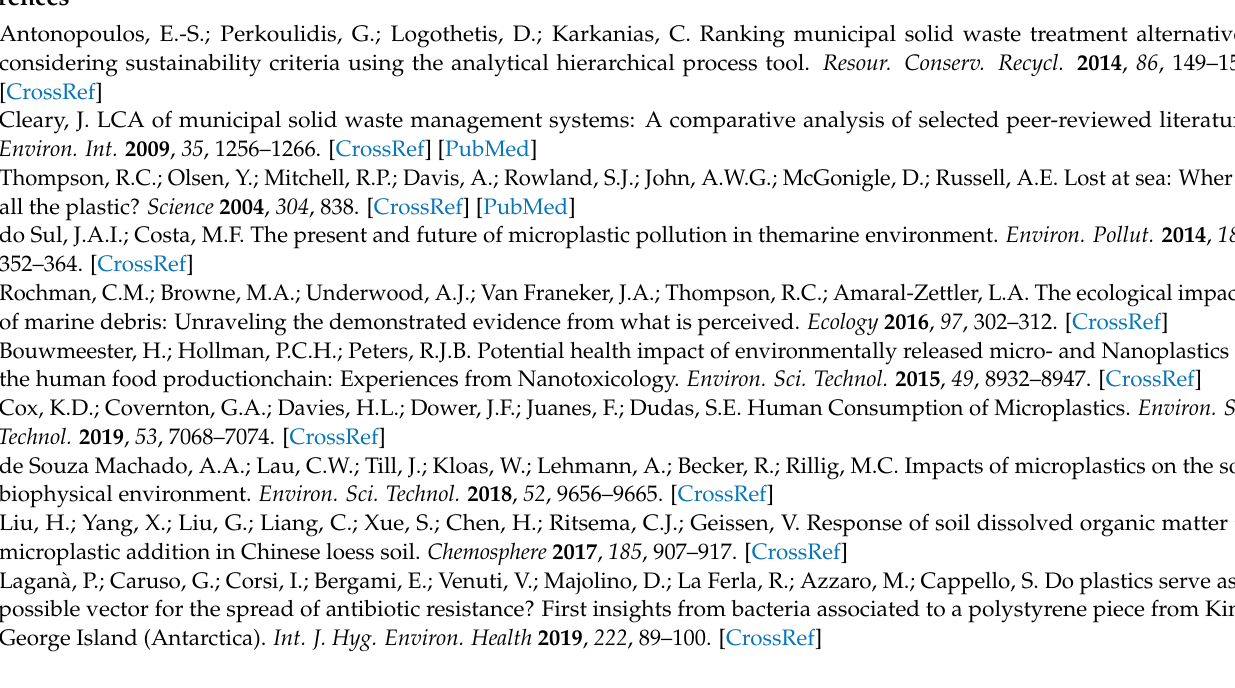
Figure S3. ESI-MS analysis of the oil precursors produced by the 1-octadecene degradation, with- out any catalyst; Figure S4. ESI-MS analysis of the oil precursors produced by the 1-octadecene degradation, catalyzed by γ -Al 2 O 3 ; Figure S5. ESI-MS analysis of the oil precursors produced by the 1-octadecene degradation, catalyzed by Ga doped γ -Al 2 O 3 ; Figure S6. ESI-MS analysis of the wax produced by the polyethylene degradation, without any catalyst; Figure S7. ESI-MS analysis of the wax produced by the polyethylene degradation, catalyzed by γ -Al 2 O 3 ; Figure S8. ESI-MS analysis of the wax produced by the polyethylene degradation, catalyzed by Ga doped γ -Al 2 O 3 ; Table S1. List of the products obtained during the polyethylene